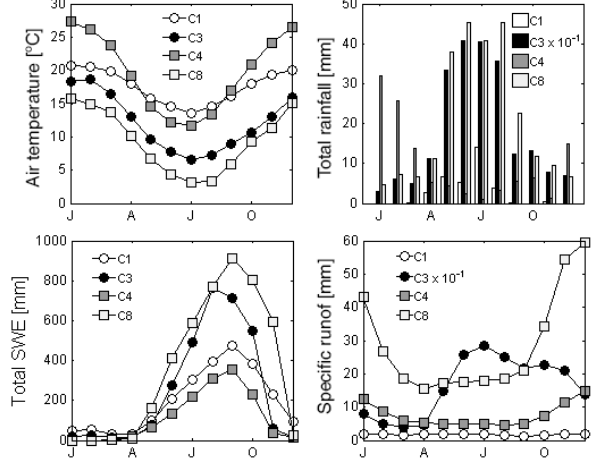
Figure 2. Summarized hydro-climatology of the model domain. Data from meteorological stations located within zones C1, C4, C3 and C8 summarized the hydro-climatological regime of the north- western, northeastern, southwestern and southeastern zones, respec- tively. Total SWE is SWE measured at selected snow-pillow sta-